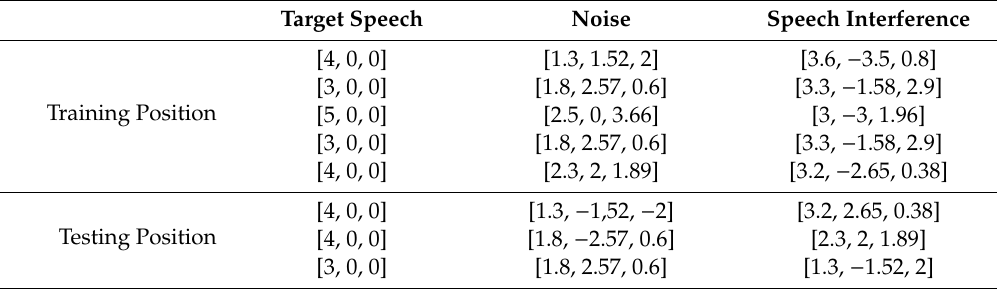
Figure 5. Simulation environment. Table 1. Di ff erent source